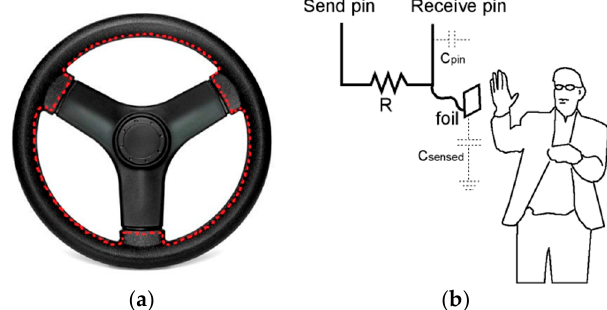
Figure 2. Driver current state sensor: a capacitive sensor is used to detect driver’s hands. ( a ) capacitive sensor sowed inside steering wheel; ( b ) Whenever the driver has one or both hands on the steering wheel, the capacity value will change [30].